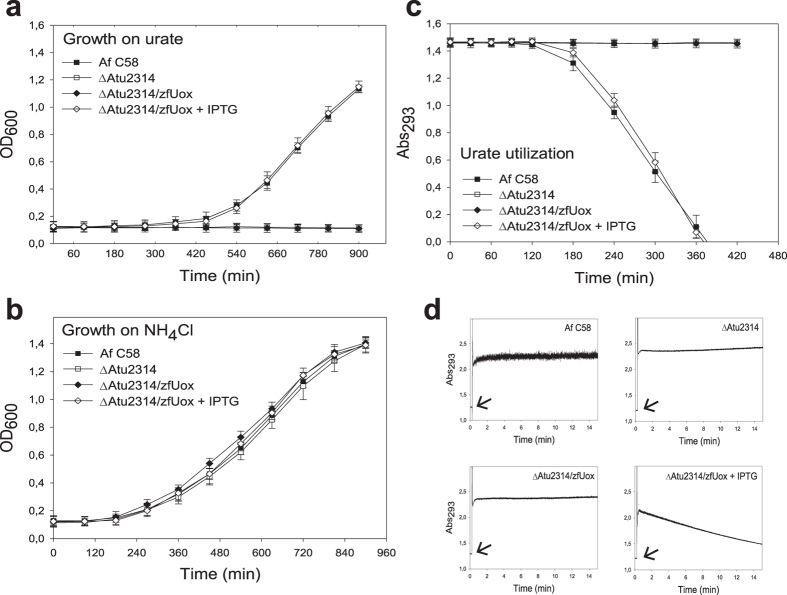
Experimental evidence for the urate oxidase activity of Atu2314 (COG3748).Growth curves of wild-type and engineered A. fabrum C58 strains in M9 minimal medium supplemented with (a) urate or (b) ammonia as nitrogen source. (c) Urate utilization by concentrated cell cultures. Error bars represent standard deviations obtained from three independent experiments. (d) Uox activity of 250 μg of cell-free extracts as monitored by the decrease in absorbance at 293 nm; extracts were added (arrows) to 0.1 ml solutions containing 0.11 mM urate.